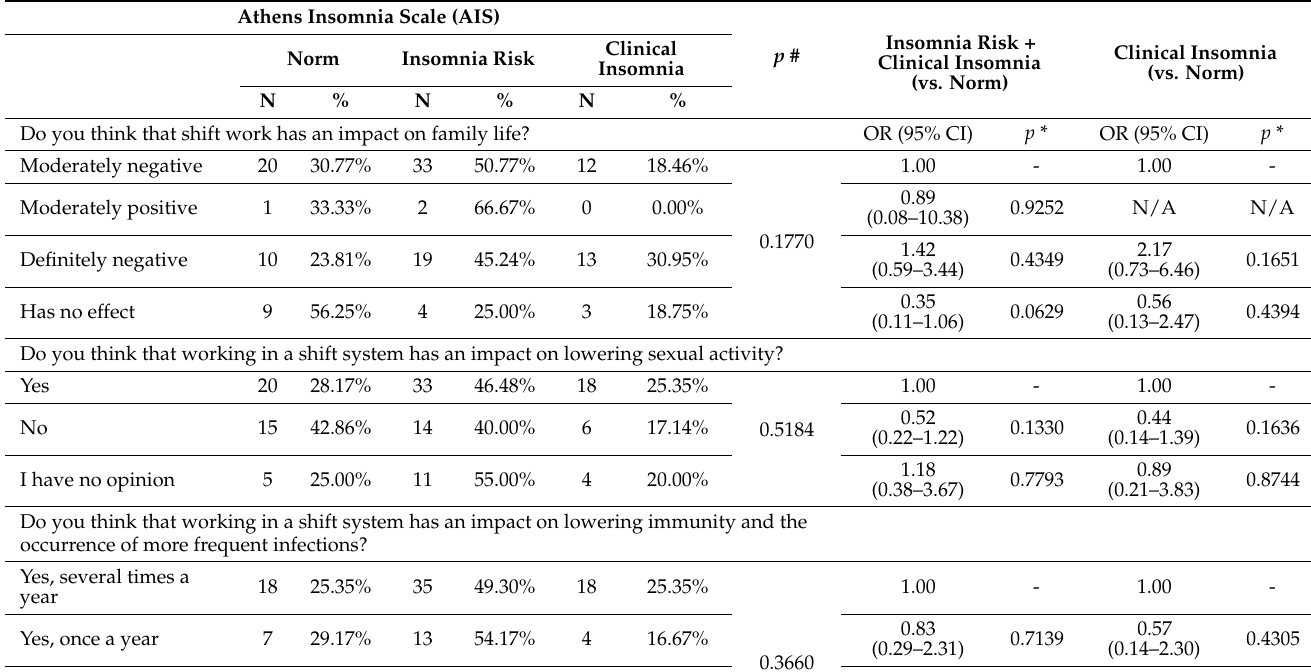
Table 9. The impact of shift work on the family life of respondents and the problems of sleep